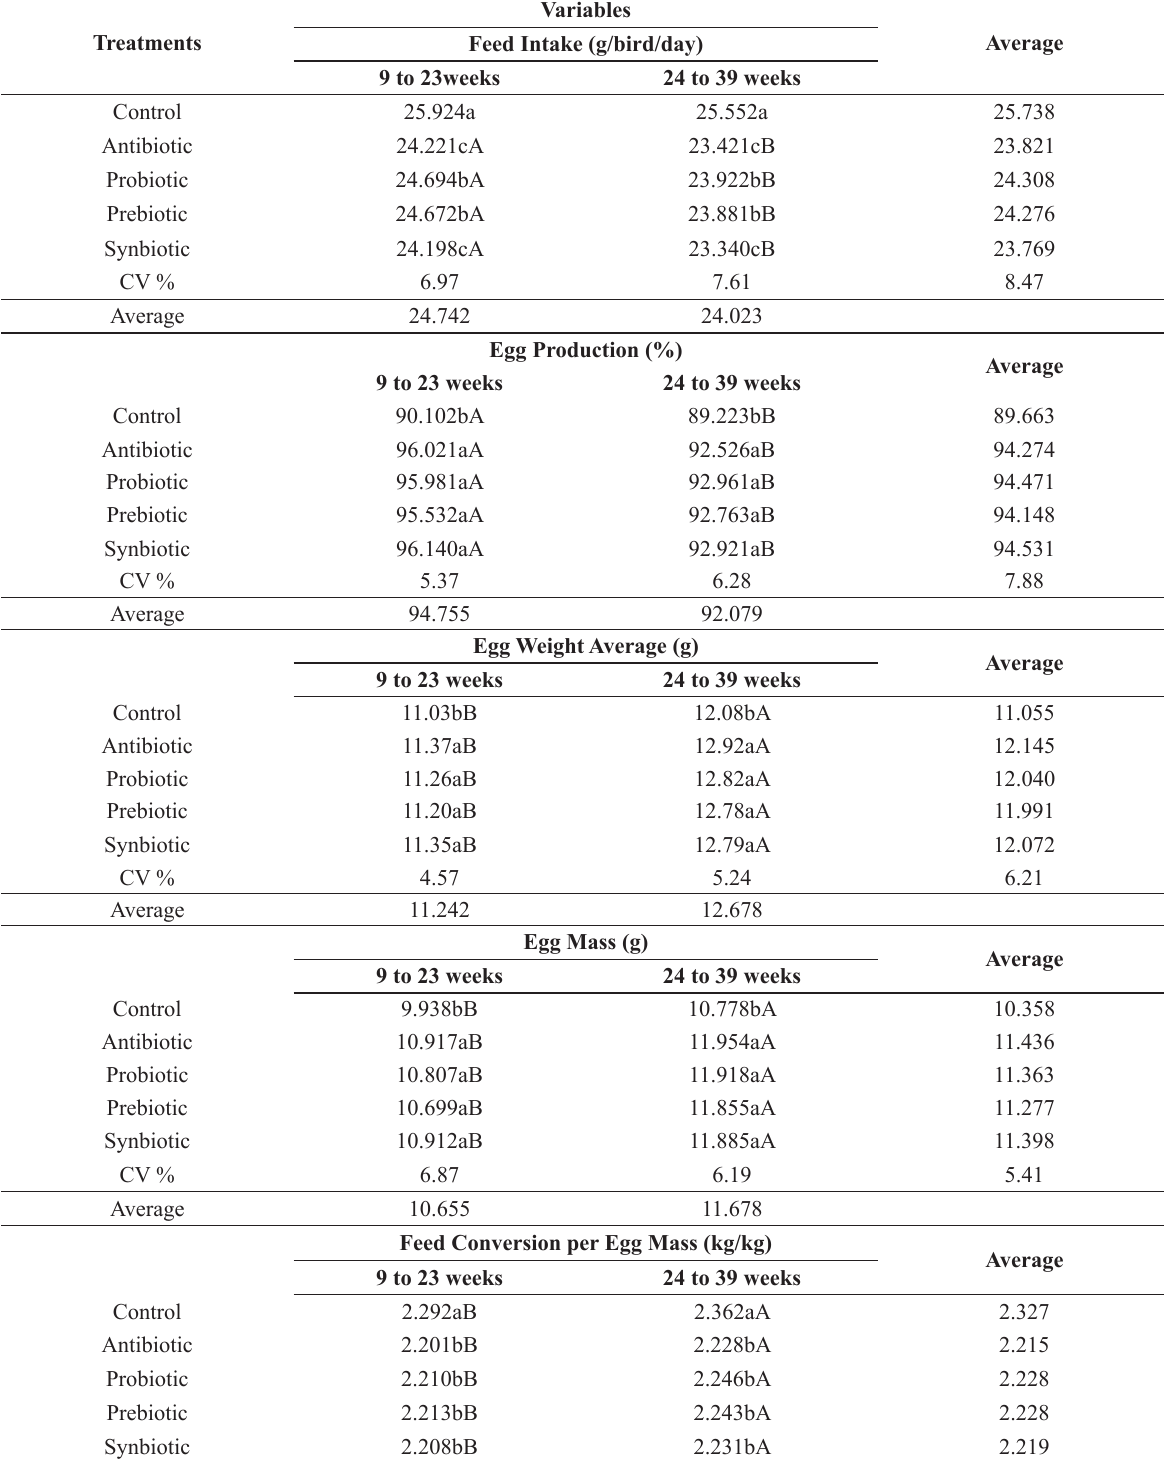
Performance of Japanese quails fed diets containing different additives in two periods during the productive